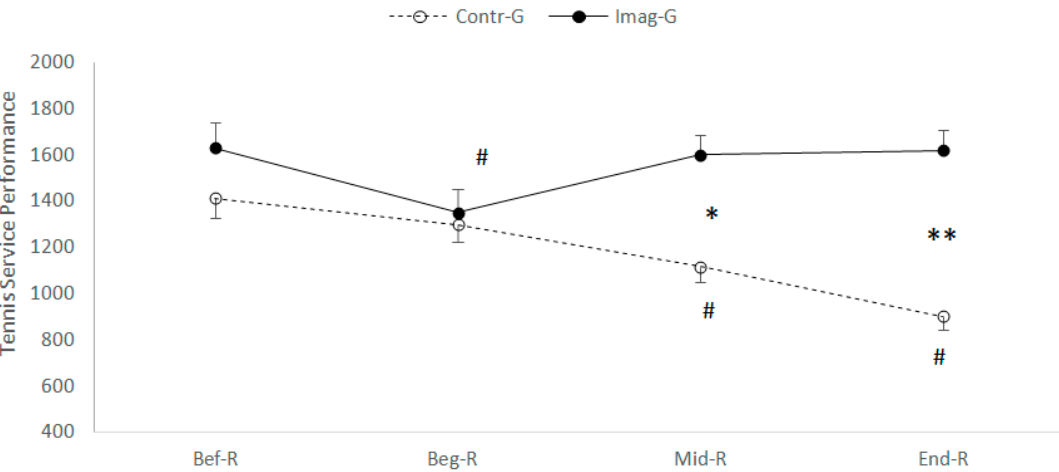
Figure 5. Mean and standard deviation of service performance, before, during and at the end of Ramadan for CG vs. IMG. *, ** Significantly different from Contr-G at p < 0.01, p < 0.001 respectively; # significantly different from Bef-R at p < 0.001.